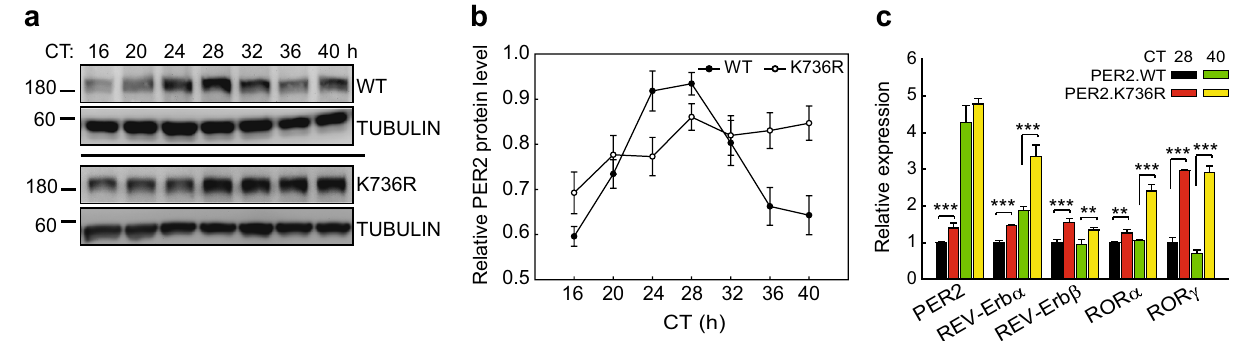
Figure 3. K736-dependent SUMO conjugation is required to maintain correct PER2 oscillation, PER2 nuclear localization, PER2-mediated transcriptional suppression and correct circadian period. ( a ) Time course assay using synchronized U2OS cells with or without CRISPR/CAS-edited PER2 K736R knock-in. After 50% serum shock, total protein was extracted at the indicated circadian time (CT). The levels of endogenous PER2 and SUMOs were determined using IB analysis. TUBULIN was used as a loading control. The membranes were cut prior to hybridization with antibodies and the original blots are shown in the “Supplementary information” file. ( b ) Quantification of relative PER2 protein levels from six time course analyses. Data are means ± SD. PER2 WT quantification data is acquired from the same IB analyses as in Fig. 1c. ( c ) Expression of PER2 and genes in auxiliary circadian loops analyzed by real-time quantitative (q)-PCR using PER2 K736R knock-in or PER2 WT control U2OS cells at CT 28 and CT 40 after serum shock. GAPDH was used as an internal control. All data points were performed in at least triplicates and all experiments were performed at least twice with similar results. Data are presented as mean ± SD, n = 3. ** p < 0.01; *** p < 0.001 (Student’s